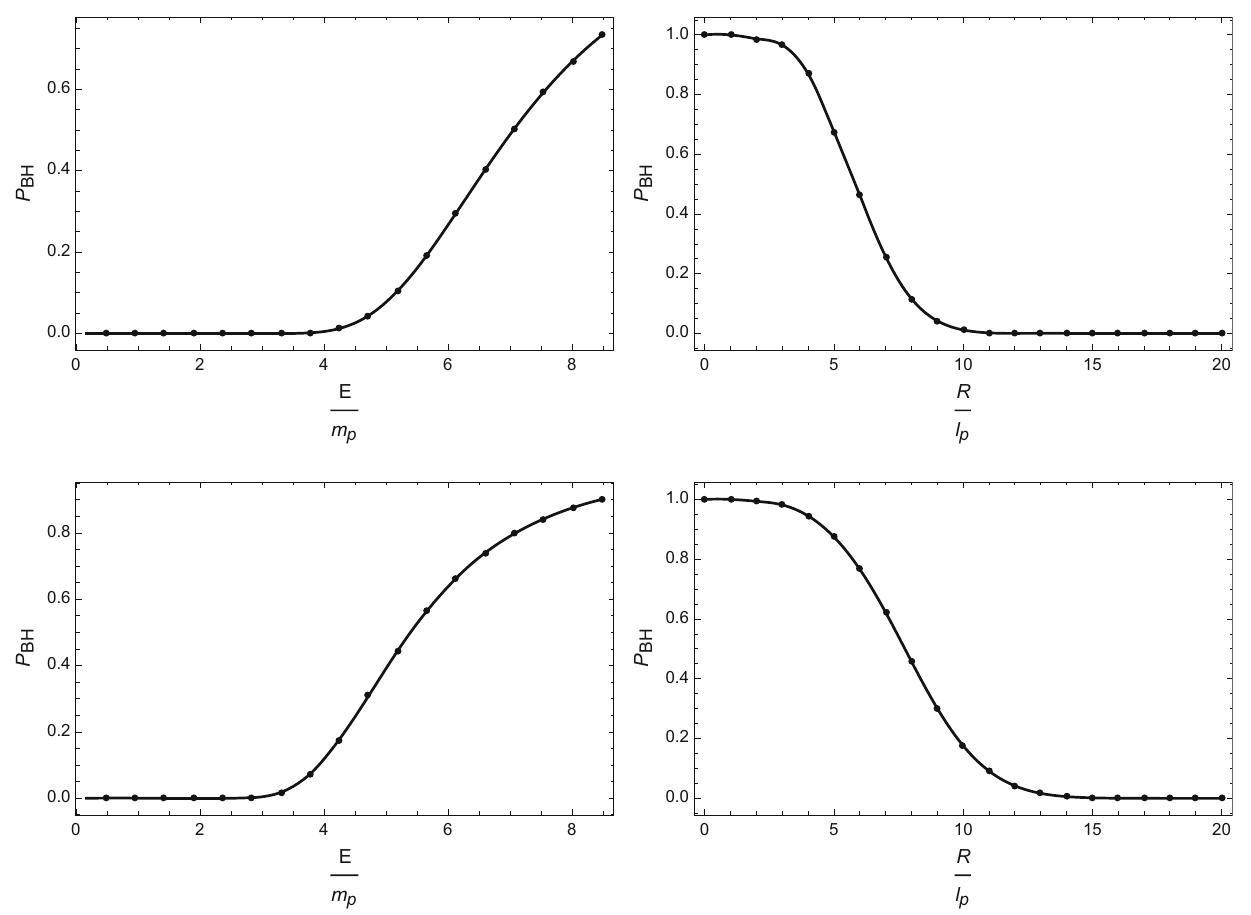
Fig. 10 Top left: Probability P BH for a system of shells with oppo- site radial momenta P 1 = P and P 2 = − P to be a black hole as a function of the total energy of the two shells for R = 10 (cid:2) p . Top right: P BH as a function of the mean radius R for P 1 = P and P 2 = − P √ and E = 3 2 m p (cid:11) 4 . 2 m p . Bottom left: P BH for a system of shells